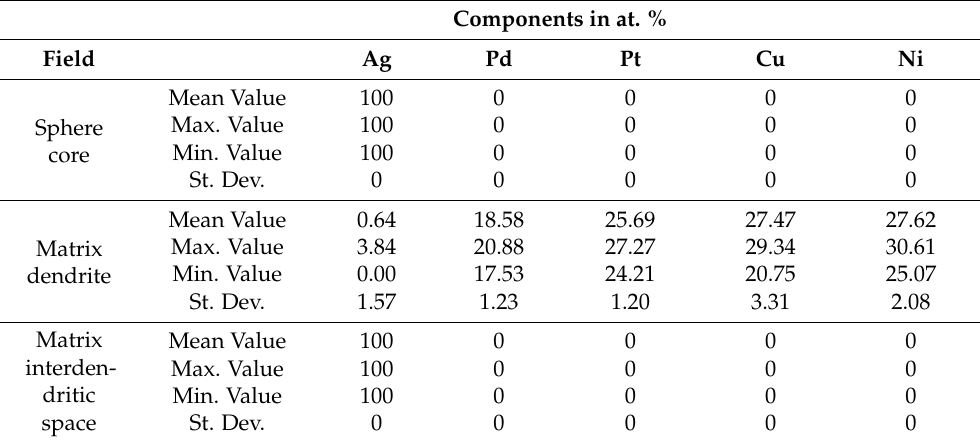
Table 2. EDS chemical analysis of individual fields (at. %) of the annealed samples. Components in at. %